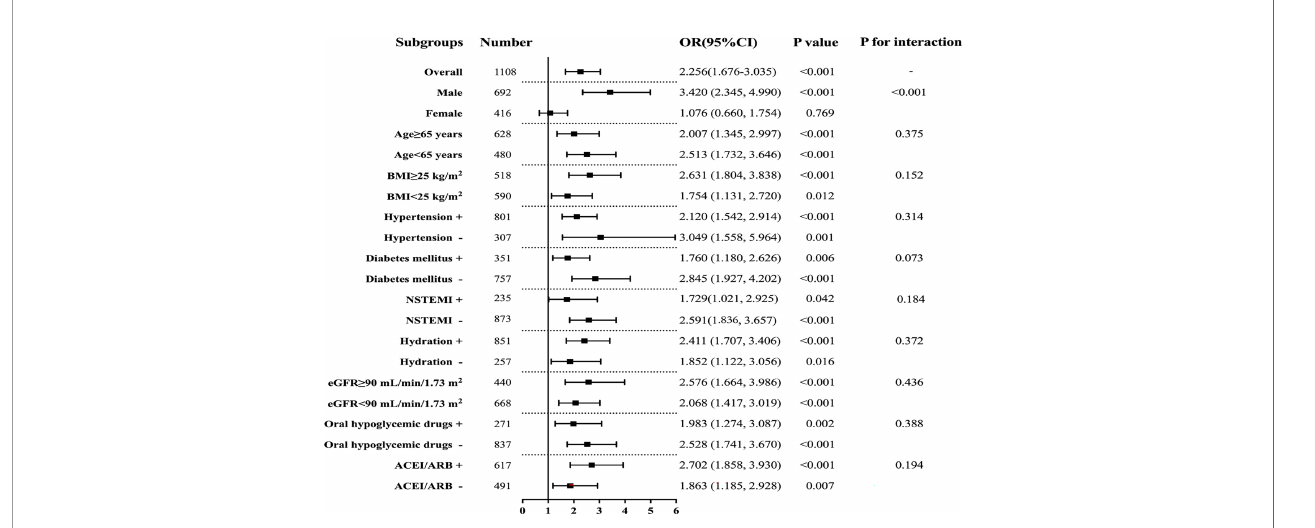
FIGURE 4 | Subgroup analyses for the association between the TyG index and CIN. Adjusted for age, female, BMI, SBP, DBP, hypertension, diabetes mellitus, CKD, NSTEMI, hydration, diuretics, the dose of contrast agent, leukocyte count, haemoglobin, SCr, LDL-C, HbA1c, multiple vessel disease, Gensini scores, oral hypoglycemic drugs, and ACEI/ARB.